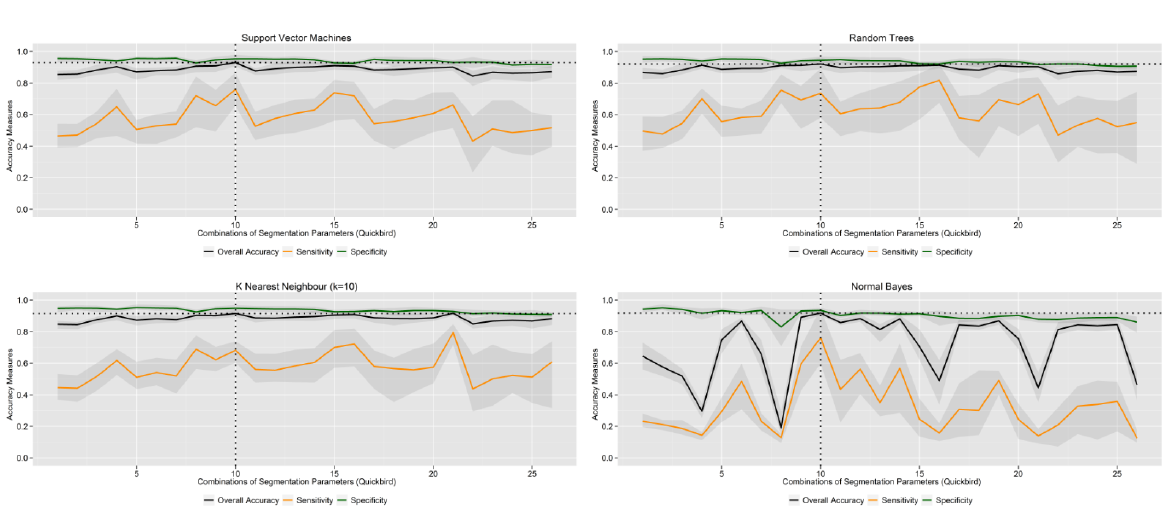
Figure 14. Influence of the segmentation inputs on the classification accuracy for QB with increasing average segment size from left to right. Mean and range of accuracy measures from the ten-fold cross-validation are shown for each iteration.